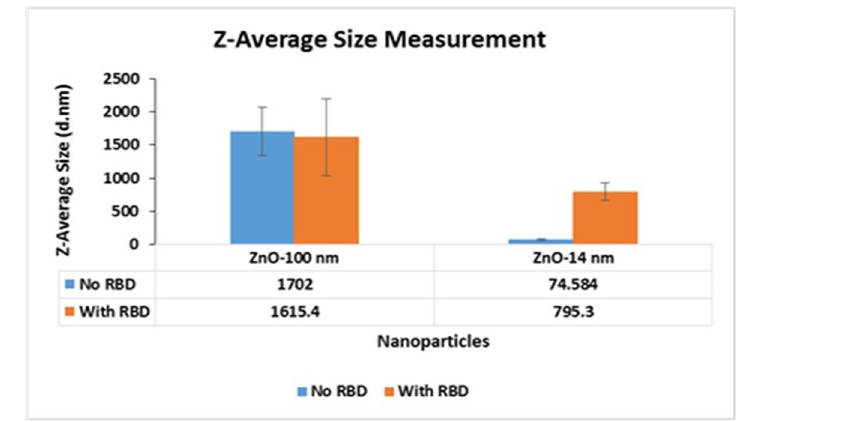
Fig 1. Size measurements of ZnO NP-100 nm and 14 nm.